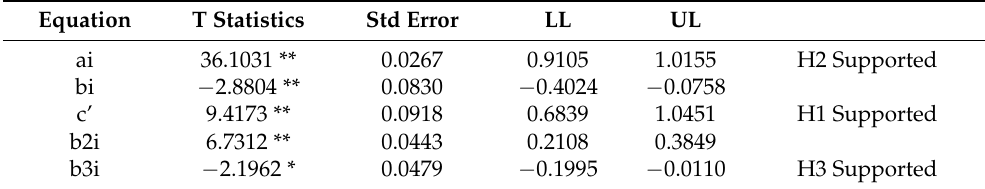
Table 1. Moderated Mediation Regression Result of Organizational